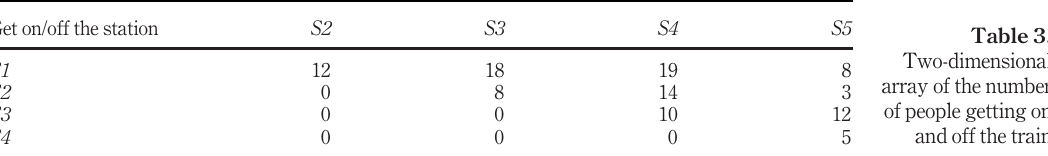
Table 3. Two-dimensional array of the number of people getting on and off the